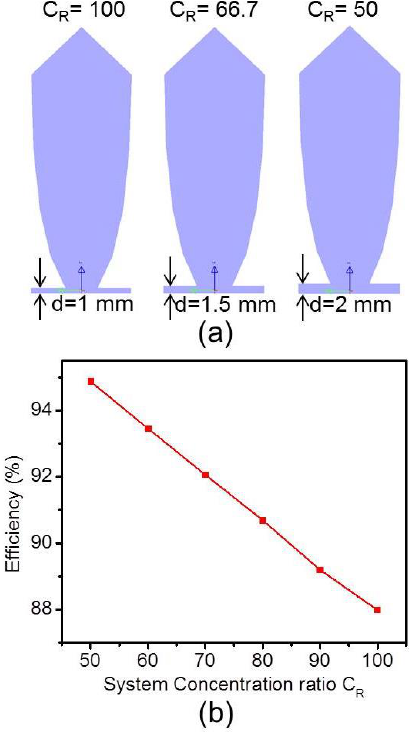
Figure 10. ( a ) The variation of the P-CPC shape; and ( b ) the variation of optical efficiency at different system concentration ratios ( C R ) .